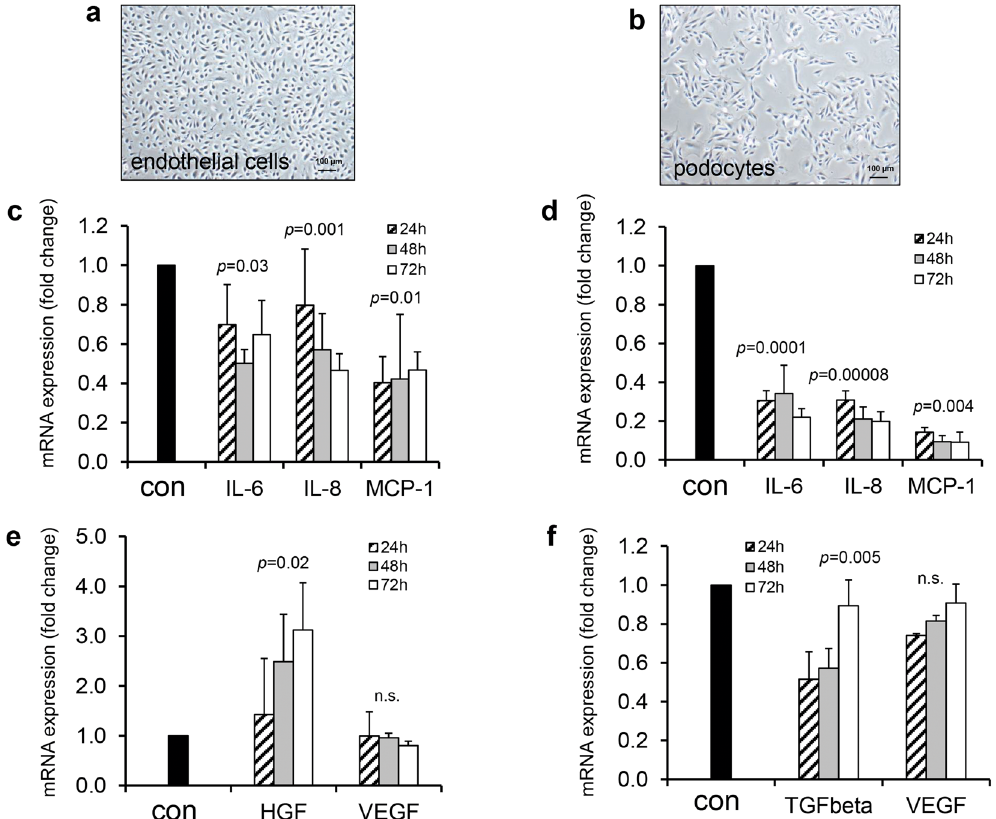
Figure 2. Influence of RSFC on human glomerular cells. Growth pattern of EC ( a ) and PO ( b ). mRNA- expression of (pro)-inflammatory ( c ) and regenerative factors ( e ) in EC and in PO ( d,f ), respectively. Of note, PO did not express HGF. Cells were cocultured with RSFC for 24, 48 and 72 h. Statistical analysis: random- slopes linear mixed models with the donor and the observation time as random effects, and the culture as fixed effects (mono- vs coculture) for that p -values are given. Values are mean ± SEM from six independent